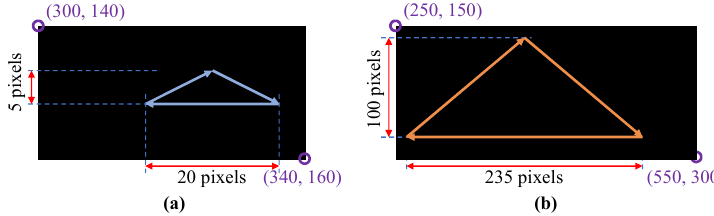
Figure 16. ( a ) moving trail of the first experiment; ( b ) moving trail of the second experiment.